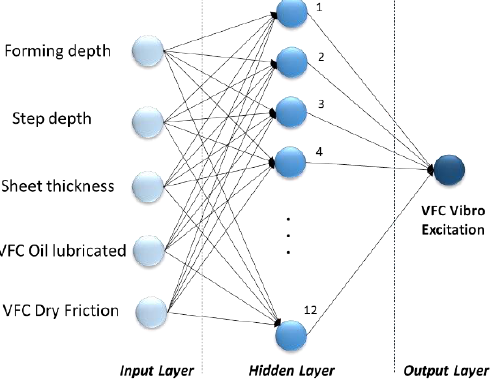
Figure 12. The architecture of used multilayer perceptron.